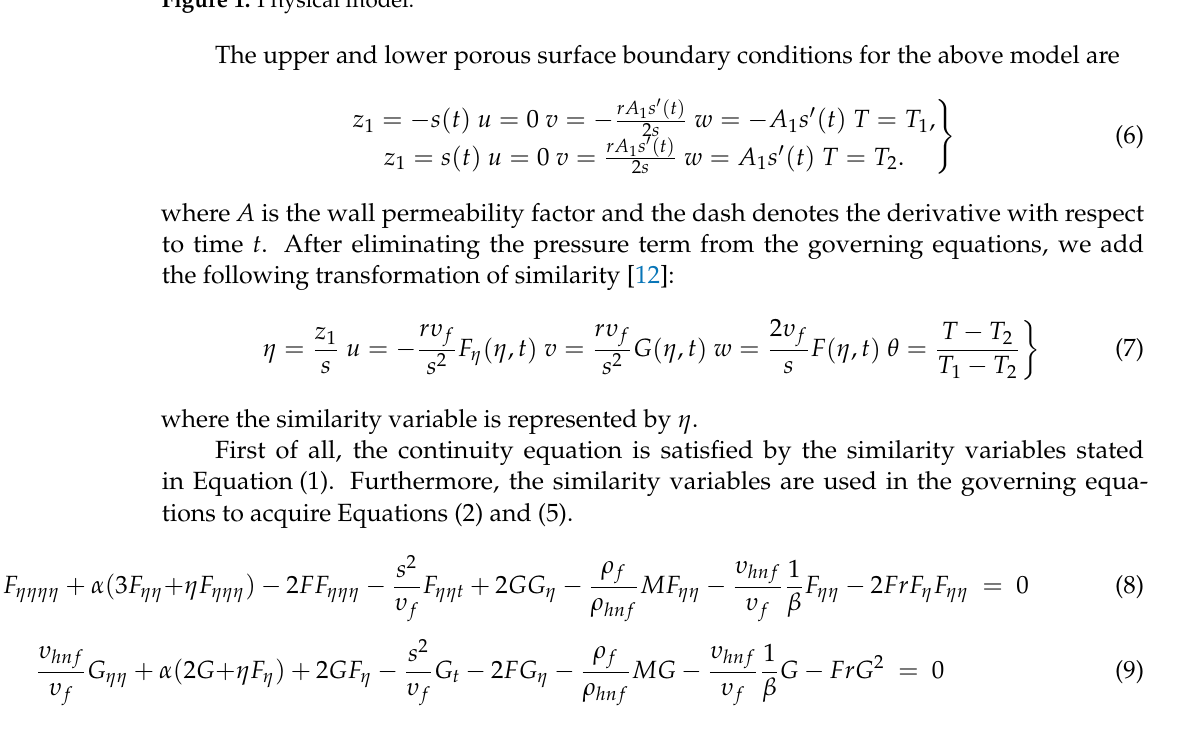
Figure 1. Physical model.